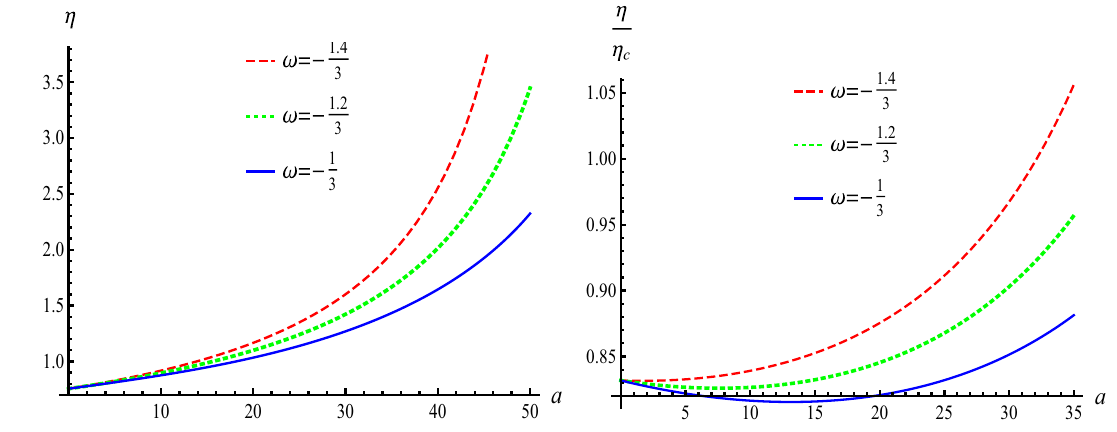
Fig. 7 The two figures above are plotted at three different fixed state parameter ω q , here we take P 1 = 4 , P 4 = 1 , S 1 = 1 , S 2 = 4 , Q =